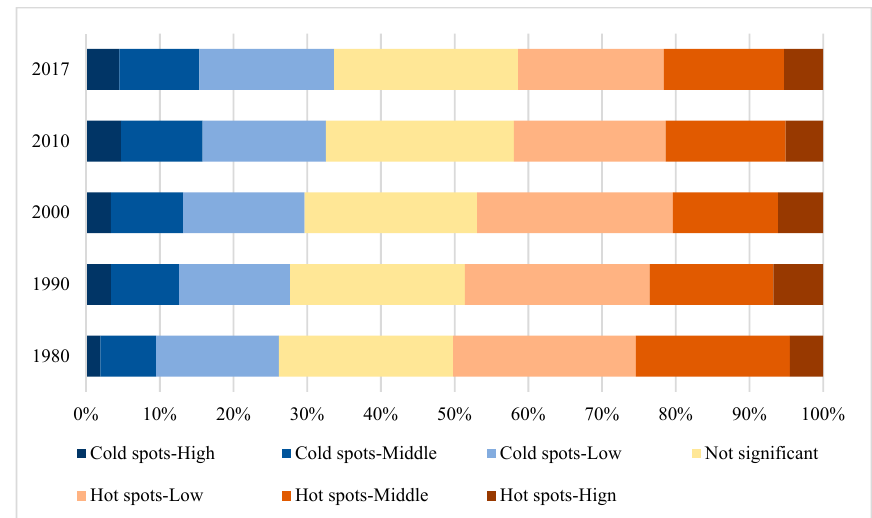
Figure 9. Change in the proportion of spatial agglomeration in the study